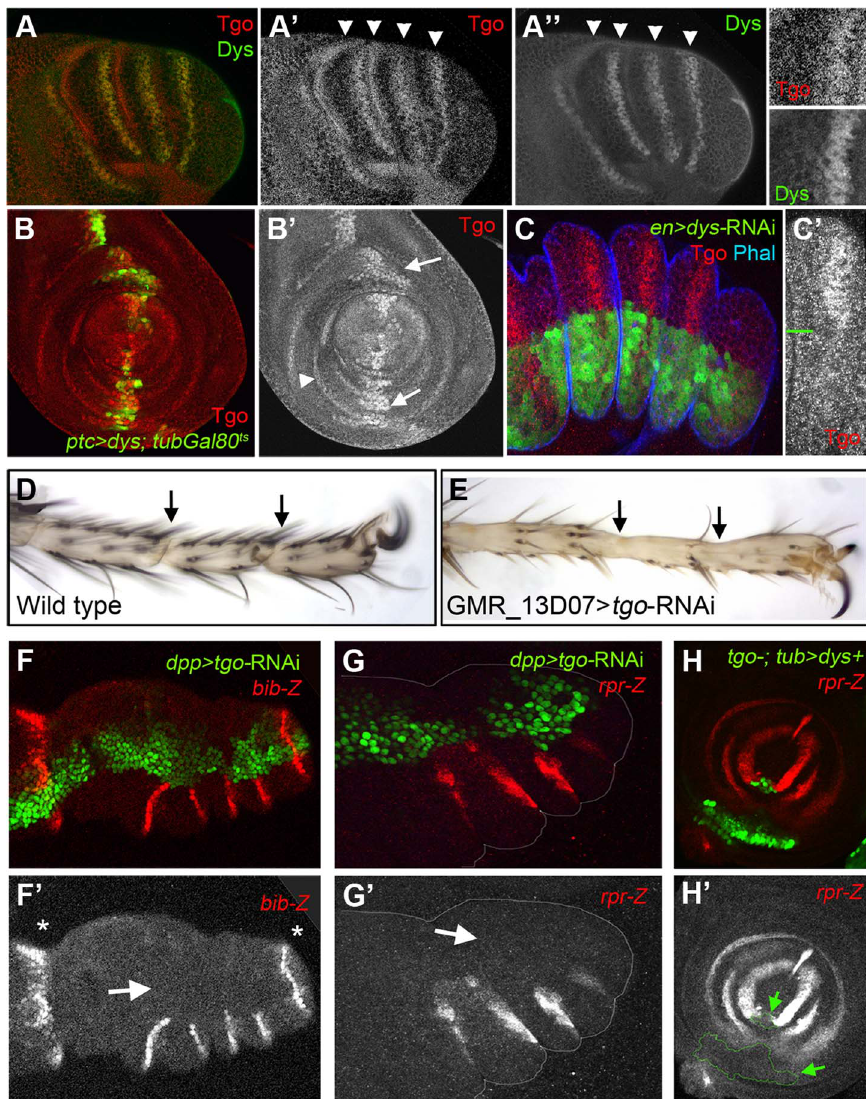
Figure 6. Tgo and Dys relationship during tarsal joint development. (A) Tgo (red) and Dys (green) co-localization in a prepupae leg. Note that Tgo nuclear protein localization coincides with that of Dys (arrowheads) in the presumptive tarsal joints. Single channels are displayed for Tgo (A 9 ) and Dys (A 0 ) and a close view of a single tarsal joint. (B) ptc-Gal4 , UAS -GFP ; UAS- dys; tubGal80 ts (green) leg imaginal disc stained for Tgo (red and single channel in B 0 ). After 24 hrs of dys misexpression, Tgo localizes to the nuclei in the ptc domain (green, arrows). tgo endogenous expression in tarsal rings is pointed out by arrowhead. (C) en-Gal4- UAS- GFP ; UAS- dys- RNAi (green) prepupal leg disc stained for Tgo (red) and Phal (blue). After Dys knockdown, Tgo is no longer detected at the nucleus. (C 9 ) A close view of a single tarsal segment is shown in which the border of compartment is marked with a green line. (D–E) View of the distal end of (D) wild type and (E) GMR_13D07 -Gal4; UAS- tgo -RNAi adult legs. No tarsal joints are formed after Tgo knockdown in the presumptive tarsal joint domain (compare D with E; arrows indicate the position of the joints). (F–G) Knockdown of Tgo function in the dpp domain (green, dpp-Gal4 , UAS -GFP ; UAS- tgo -RNAi) strongly downregulates bib-Z (red in F) and rpr-Z (red in G) expression in prepupal leg discs. Note that no effect is observed in the tibial/tarsal or tarsal/pretarsal bib-Z expression (asterisks). Single channels for bib-Z (F 9 ) and rpr-Z (G 9 ) are displayed below. (H) tgo 5 mutant clones that also expressed dys under the tub promoter are marked by GFP (green) loose rpr-lacZ expression (red). (H 9 ) Single channel for rpr-Z is displayed below, and the clone is outlined